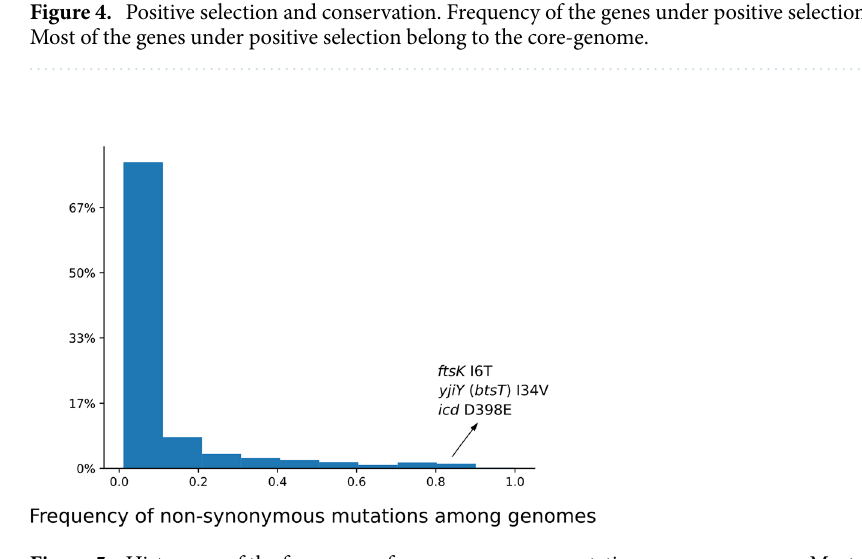
Figure 5. Histogram of the frequency of non-synonymous mutations among genomes. Most of the non- synonymous mutations in core genes are not core